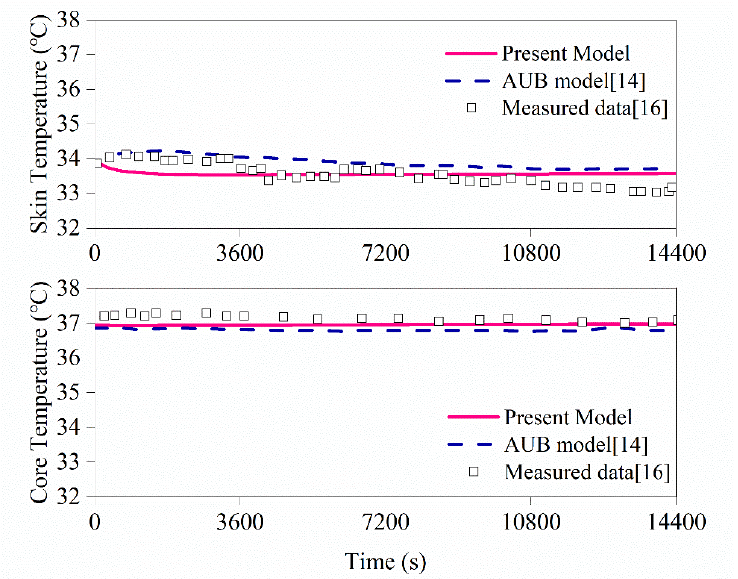
Figure 4. Comparison of simulated results of the model used in this study with the published experimental data [16], and simulated results of American University of Beirut model (AUB model) [14] for skin temperature and core temperature at constant ambient conditions of 28.5 °C /31% RH.